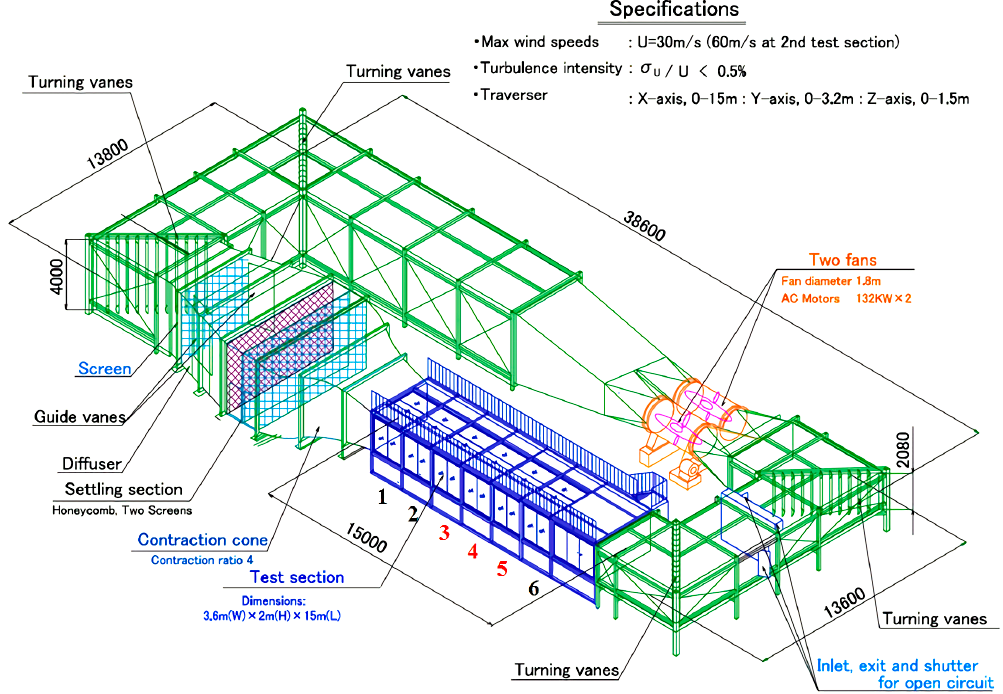
Figure 2. Wind-tunnel facility used in this study.